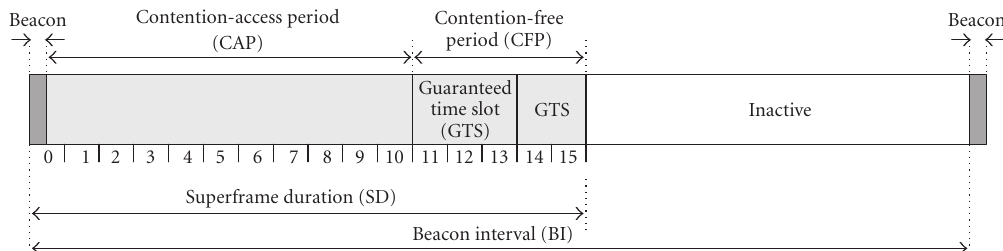
Figure 2: The composition of the superframe under IEEE Std 802.15.4 (adopted from